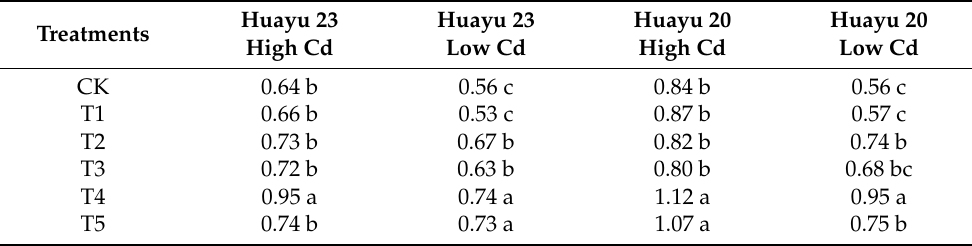
Table 6. Phytochelatin content ( µ mol · g − 1 ) of Huayu 23 and Huayu 20 under different treatments. Treatments